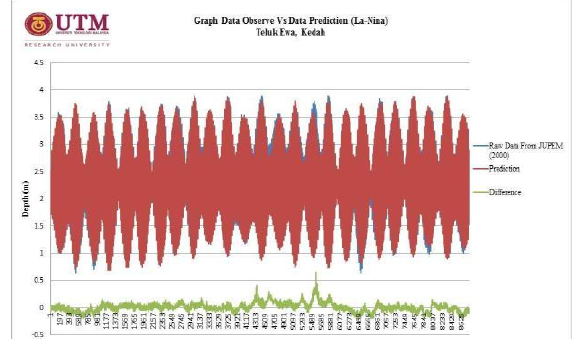
Figure 24. Graph of Comparison between Data Observed and Data Prediction